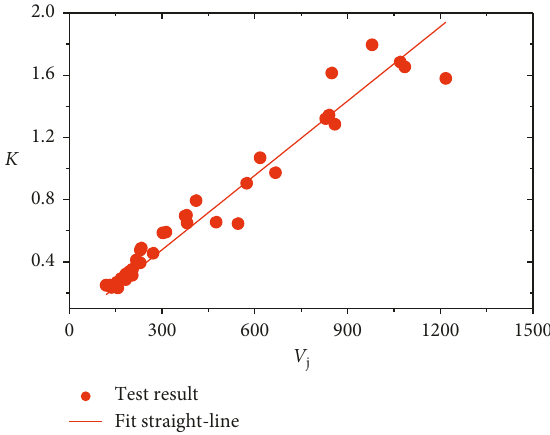
Figure 6: Regression curve of K − V